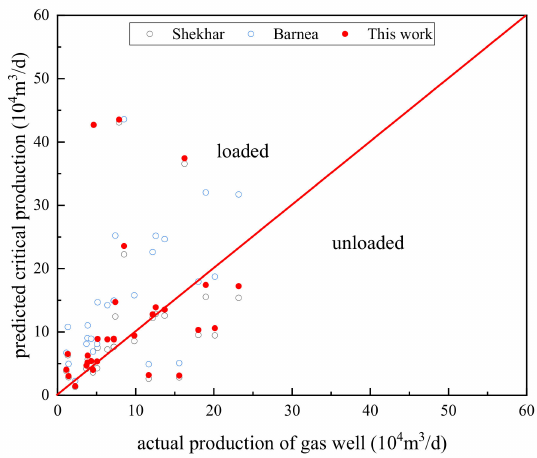
Figure 15. Comparison of prediction results of each model (Turner loaded